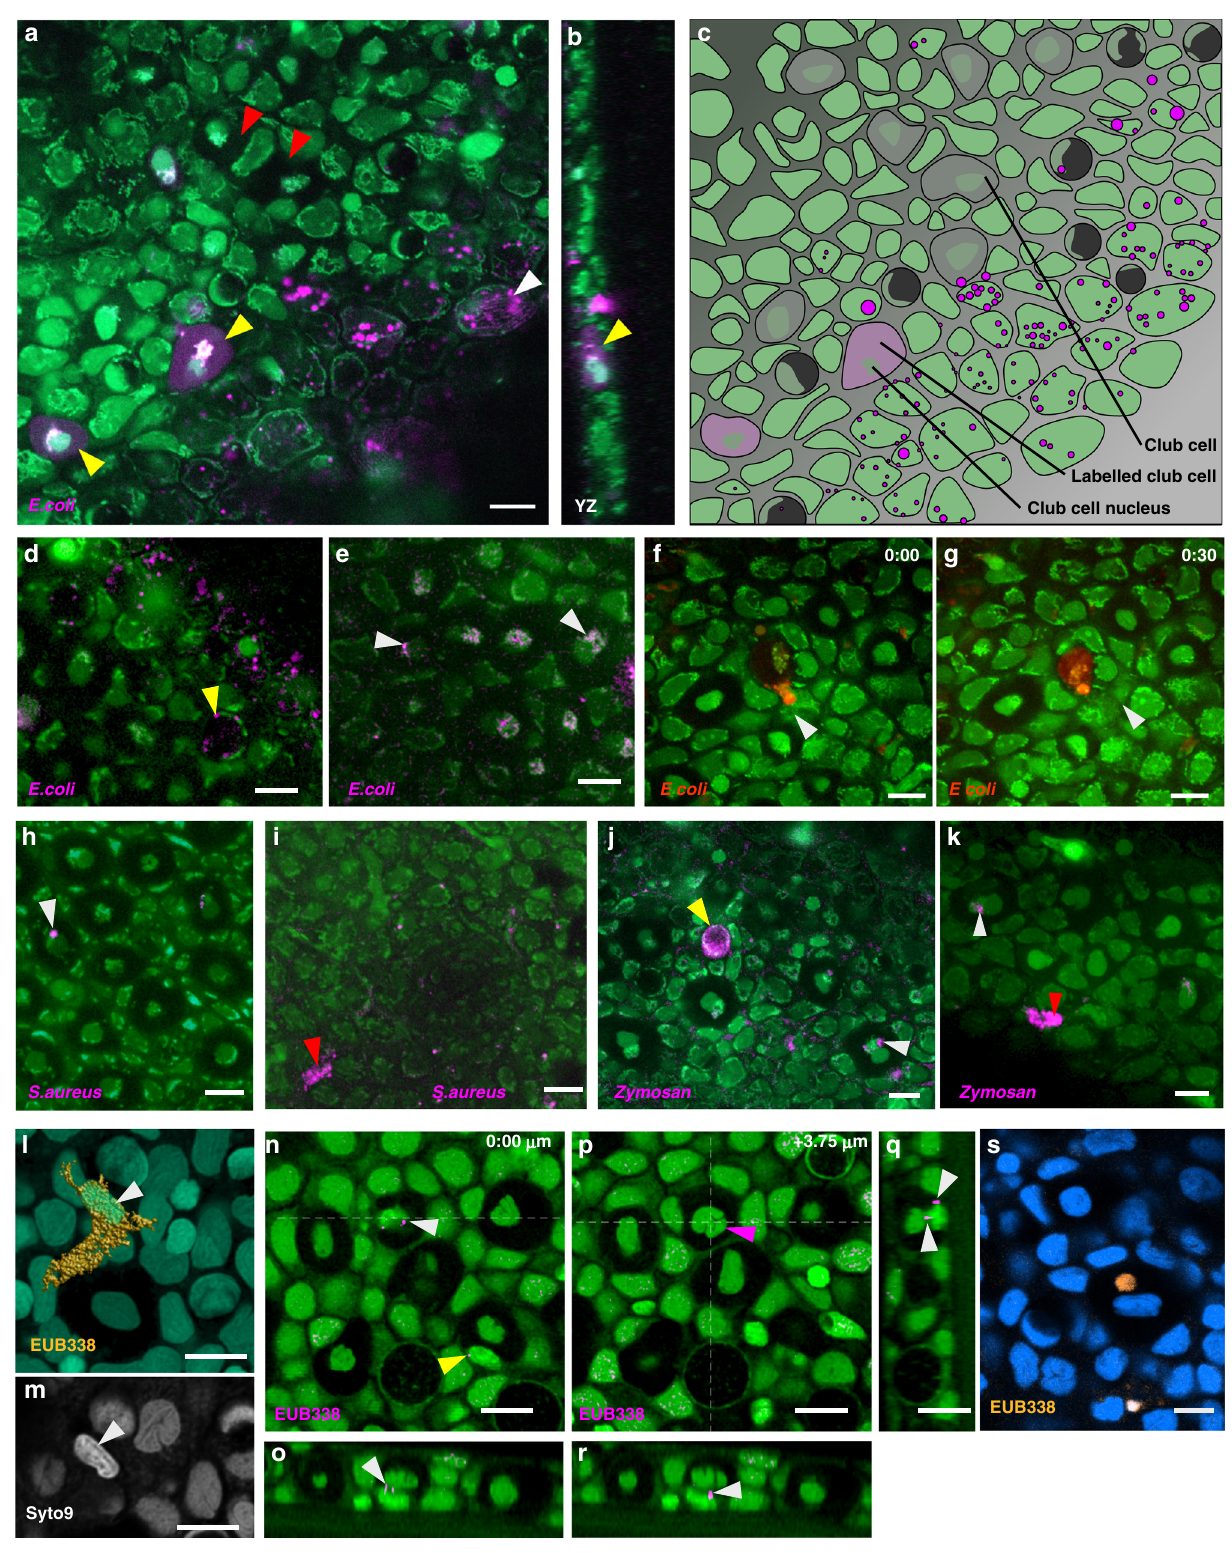
change of 0.263 [95%CI − 0.181, 0.593] for conventional fi sh. Therefore, both germ-free and conventional lysates are able to evoke darting and bottom-dwelling behavior. In contrast, the extent of freezing was lower for germ-free lysate (Fig. 6b), with conventional lysate causing an average of 204.5 s freezing [95%CI 172.3, 228.5] compared with the 59.8 s [95%CI 8.0, 164.0]